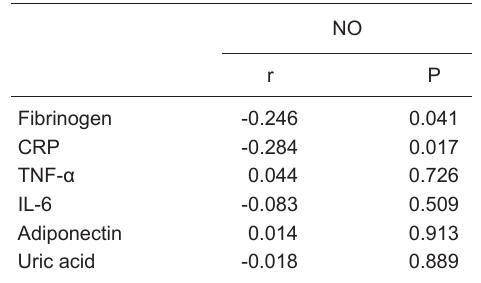
Table 3. Spearman’s analysis of the correlation of plasma nitric oxide (NO) with plasma uric acid and inflammatory markers in patients with metabolic syn -